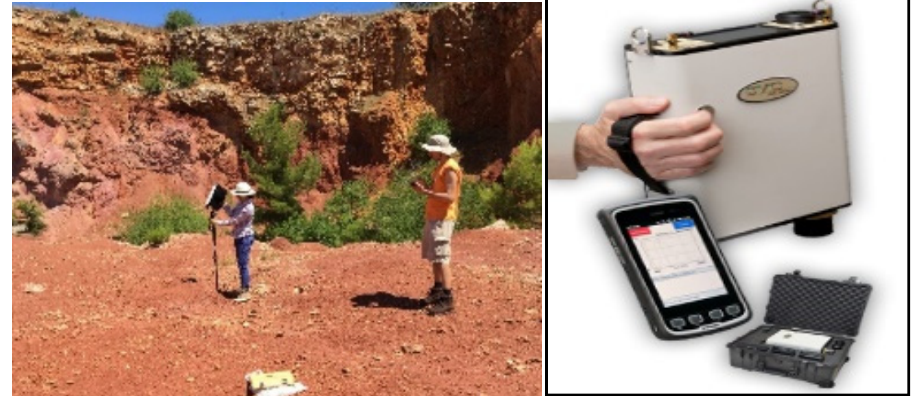
Figure 3. Spectroradiometer measurements of bauxite residues in Apulia.